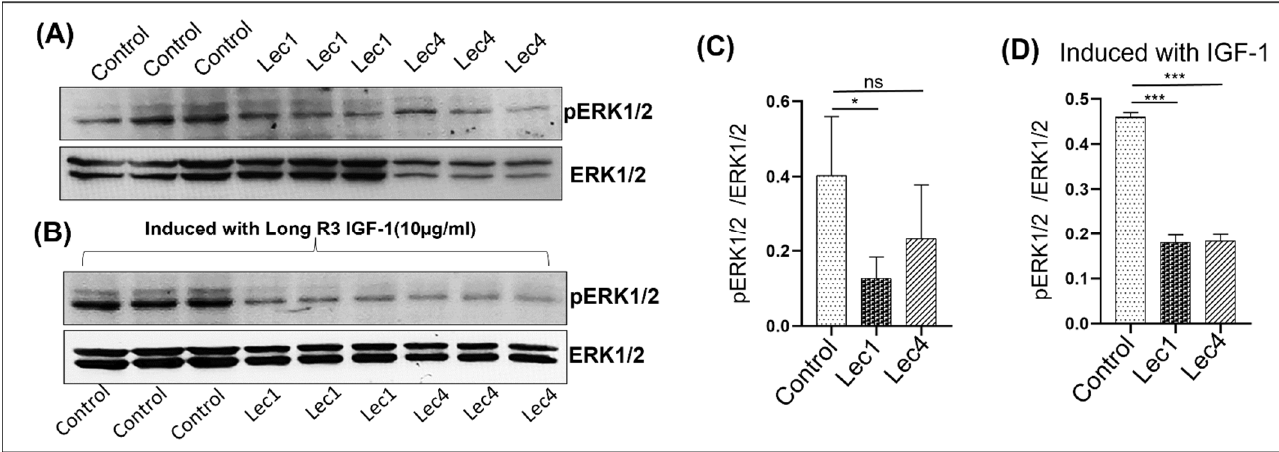
Figure 8. IGF-1 induced IGF-1R-mediated signaling activation. ( A ) Cells were incubated in serum-free medium for 12 h. Protein lysates were analyzed by WB for phosphorylated ERK 1/2(pERK1/2) and ERK1/2 as a loading control. ( B ) Cells were then treated with IGF-1 ligand (10 ug/mL) for 30 min. Protein lysates were analyzed by WB for phosphorylated ERK 1/2(pERK1/2) and ERK1/2 as a loading control. ( C ) Signals were quantified by densitometry, normalized to ERK1/2, and expressed as the ratio of (pERK1/2)/(ERK1/2) in W5, Lec1, and Lec4 cells without stimulation with ligands. ( D ) Signals were quantified by densitometry, normalized to ERK1/2, and expressed as the ratio of (pERK1/2)/(ERK1/2) in W5, Lec1 and Lec4 cells with stimulation with ligands. Data correspond to the mean ±SEM. * p value = 0.05, *** p value < 0.001 and ns = nonsignificant.